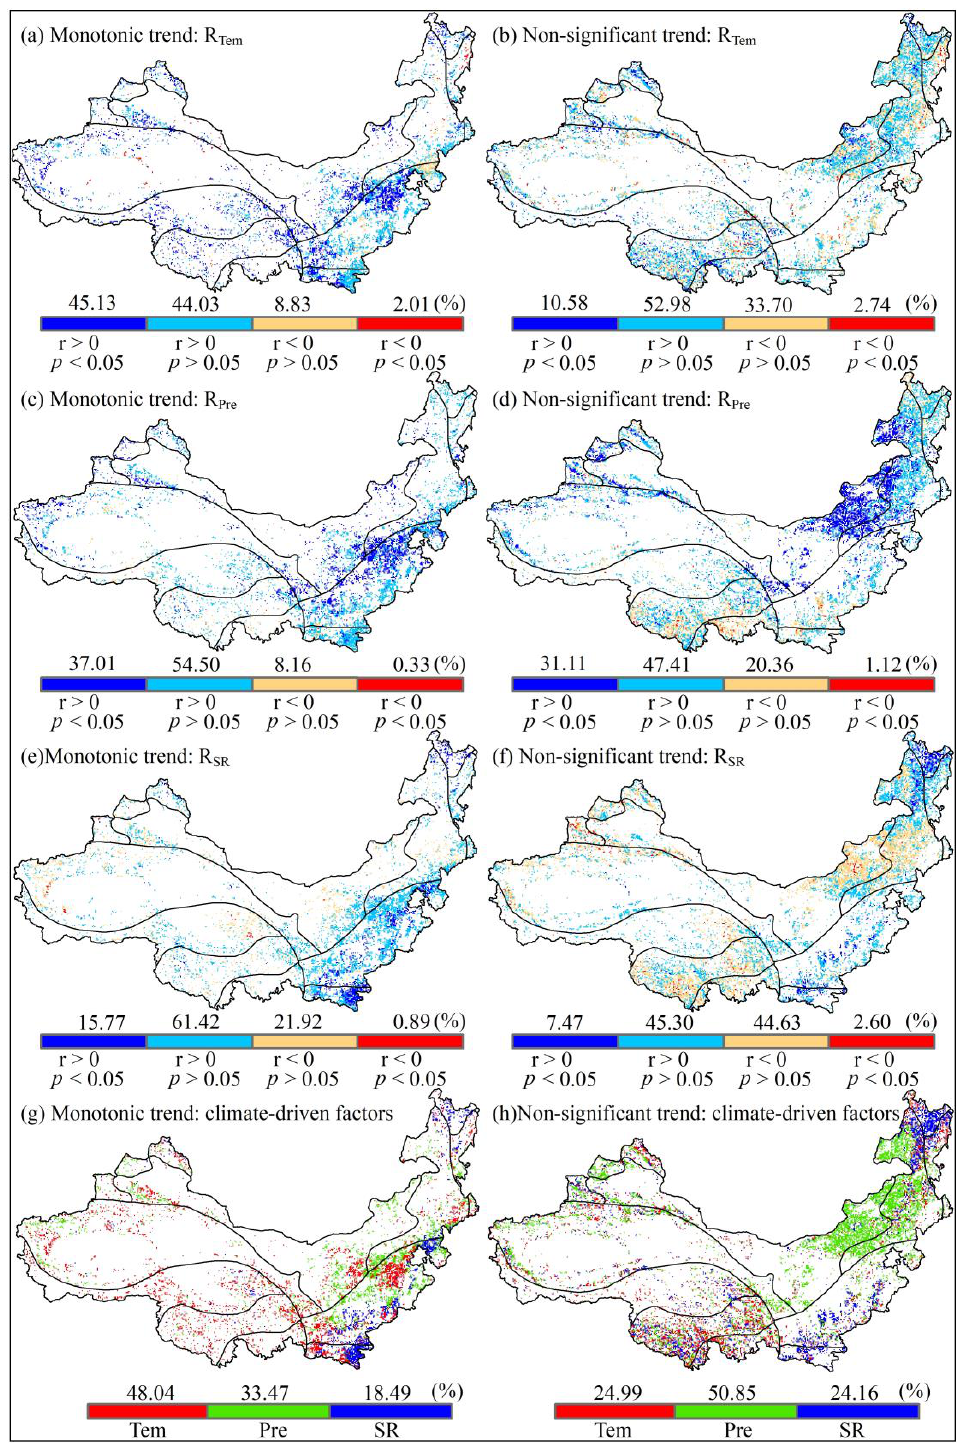
Figure 8. The significance of PCC between NDVI with monotonic trend and non-significant trend and temperature ( a , b ), precipitation ( c , d ) and solar radiation ( e , f ) and the spatial distribution pattern of climate control factor ( g , h ) in the growing season. Tem, Pre, SR represent temperature, precipitation, and solar radiation, respectively.